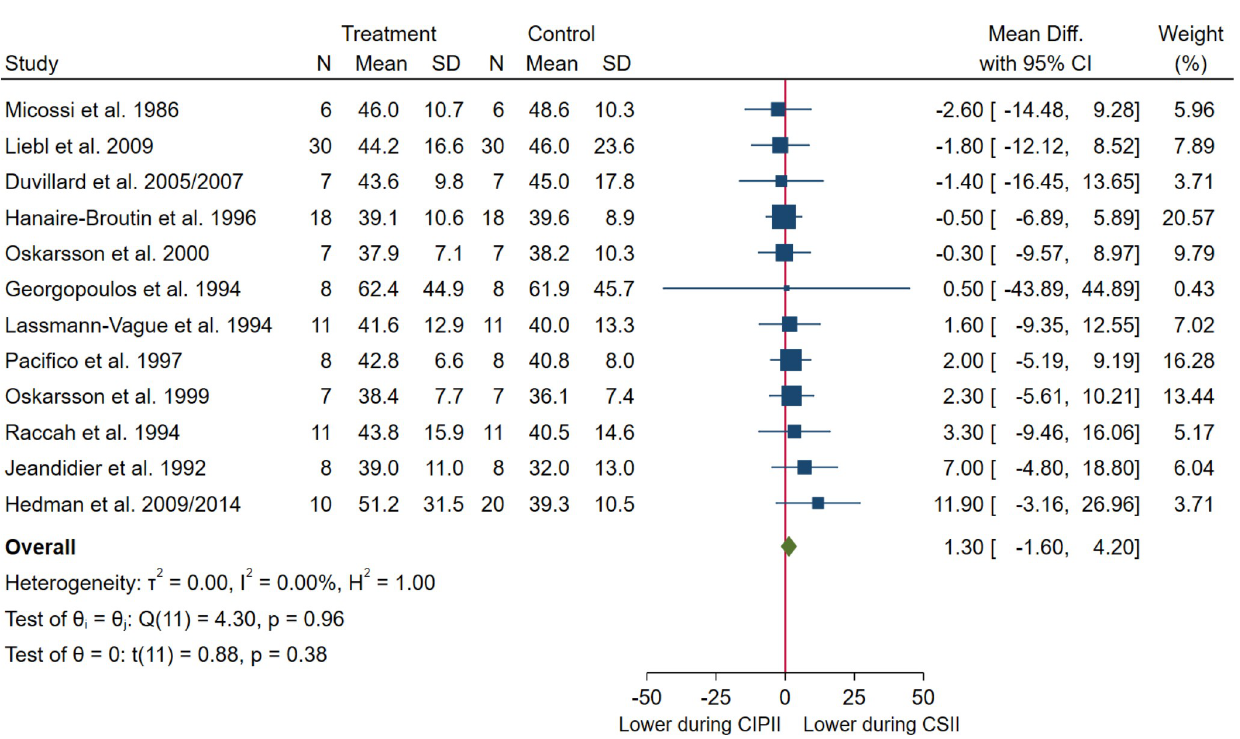
Fig 6. Meta-analysis of mean daily insulin (U/24 hours) in patients during CIPII treatment compared to that during control treatment (CSII). Treatment, continuous intraperitoneal insulin infusion (CIPII); Control, continuous subcutaneous insulin infusion (CSII). Studies ordered by effect size (mean